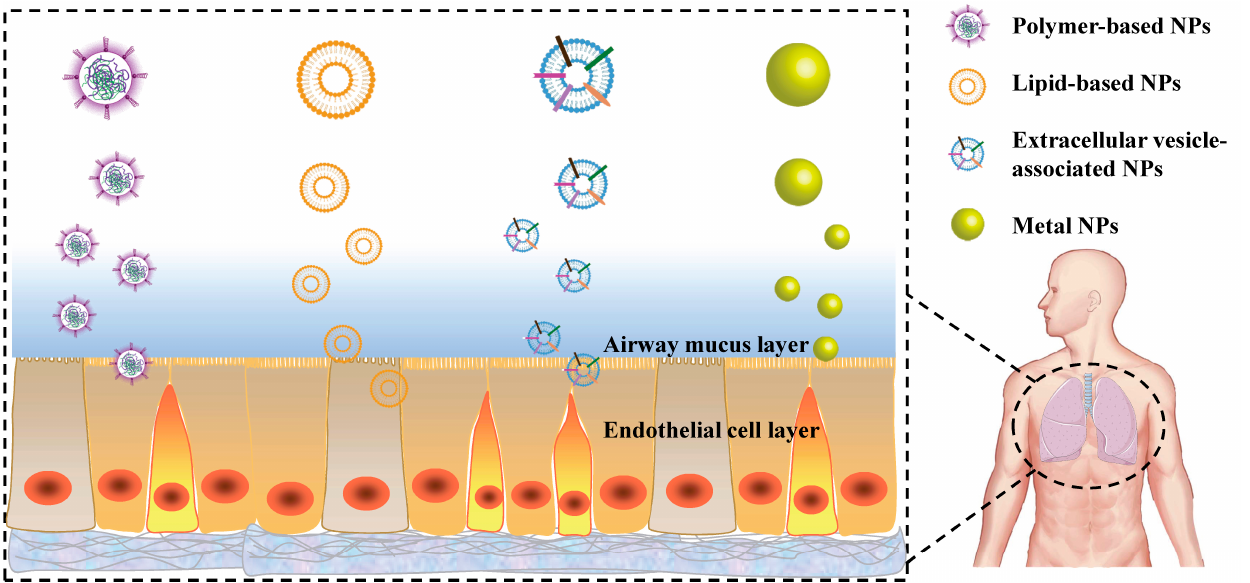
Figure 1. Variety of nanoparticles (NPs) used in the treatment of asthma.